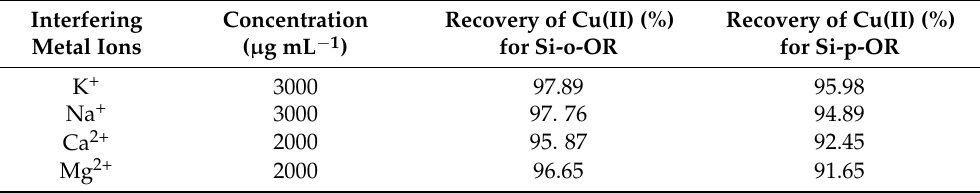
Table 4. Effect of interfering ions on the recovery of Cu(II) ions adsorbed on both sorbents (concentration of Cu(II) ion is 0.05 µ g mL − 1 ).